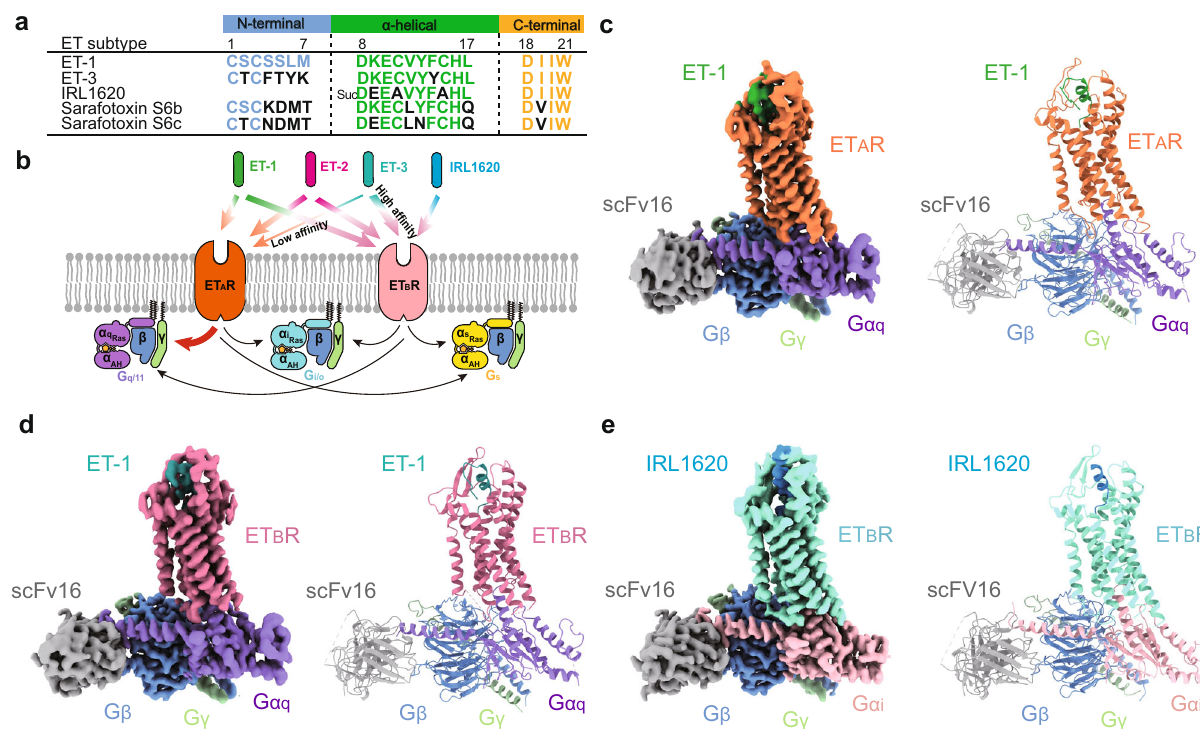
Fig. 1 | Cryo-EM structuresofET-1-ET A R-G q , ET-1-ET B R-G q , and IRL1620-ET B R-G i complexes. a Sequence comparison of peptides, including ET-1, ET-3, IRL1620, sarafotoxin S6b, and S6c. The N-terminal, α -helical, and C-terminal regions of peptides arecolored blue,green, and yellow, respectively. Residuesdifferent from that of ET-1 are colored black. b Schematic illustration of G protein-coupling of